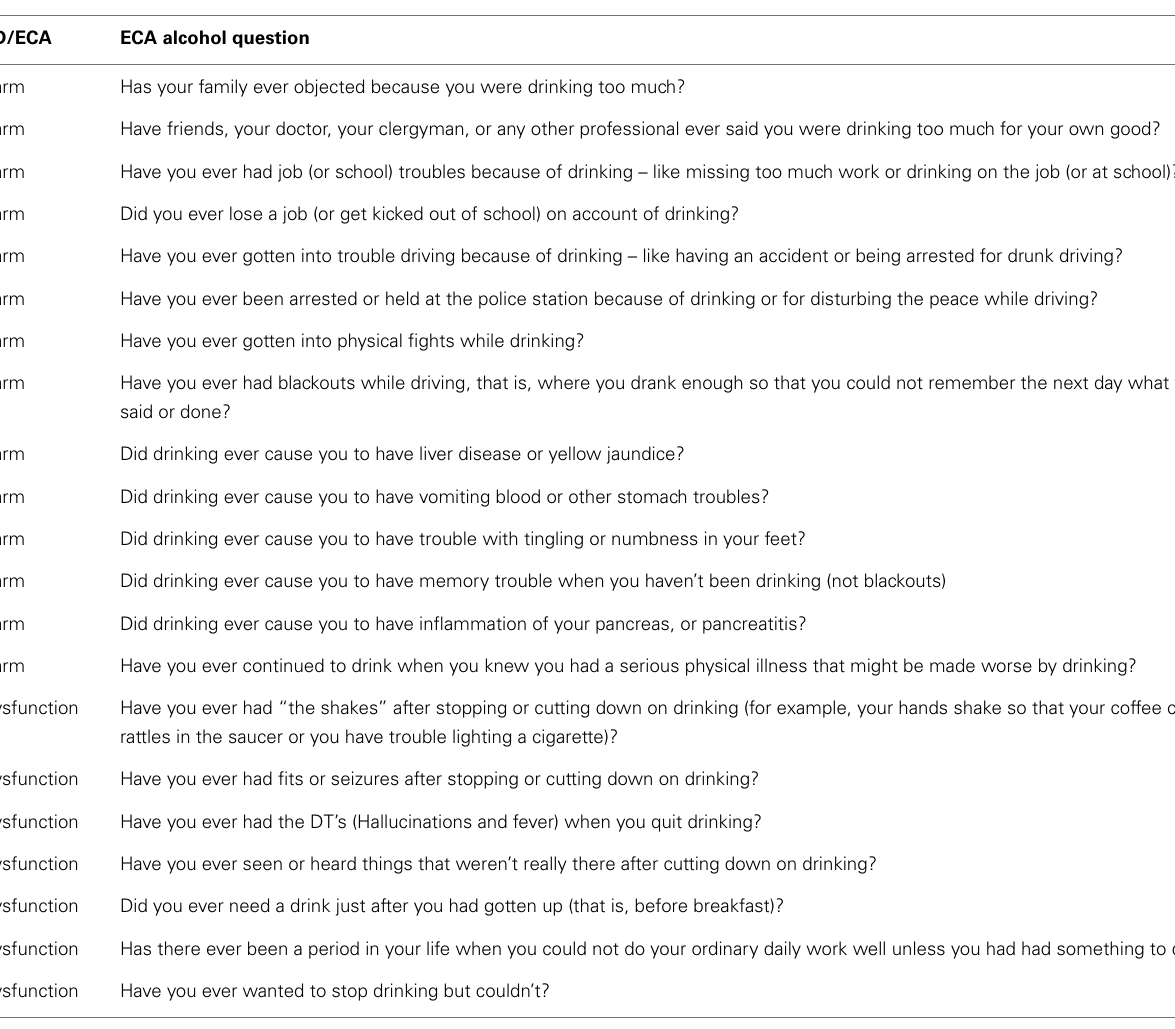
TableA3 | Harmful dysfunction (HD) diagnostic categories of harm and dysfunction and how they were translated using epidemiologic catchment area study (ECA) questions